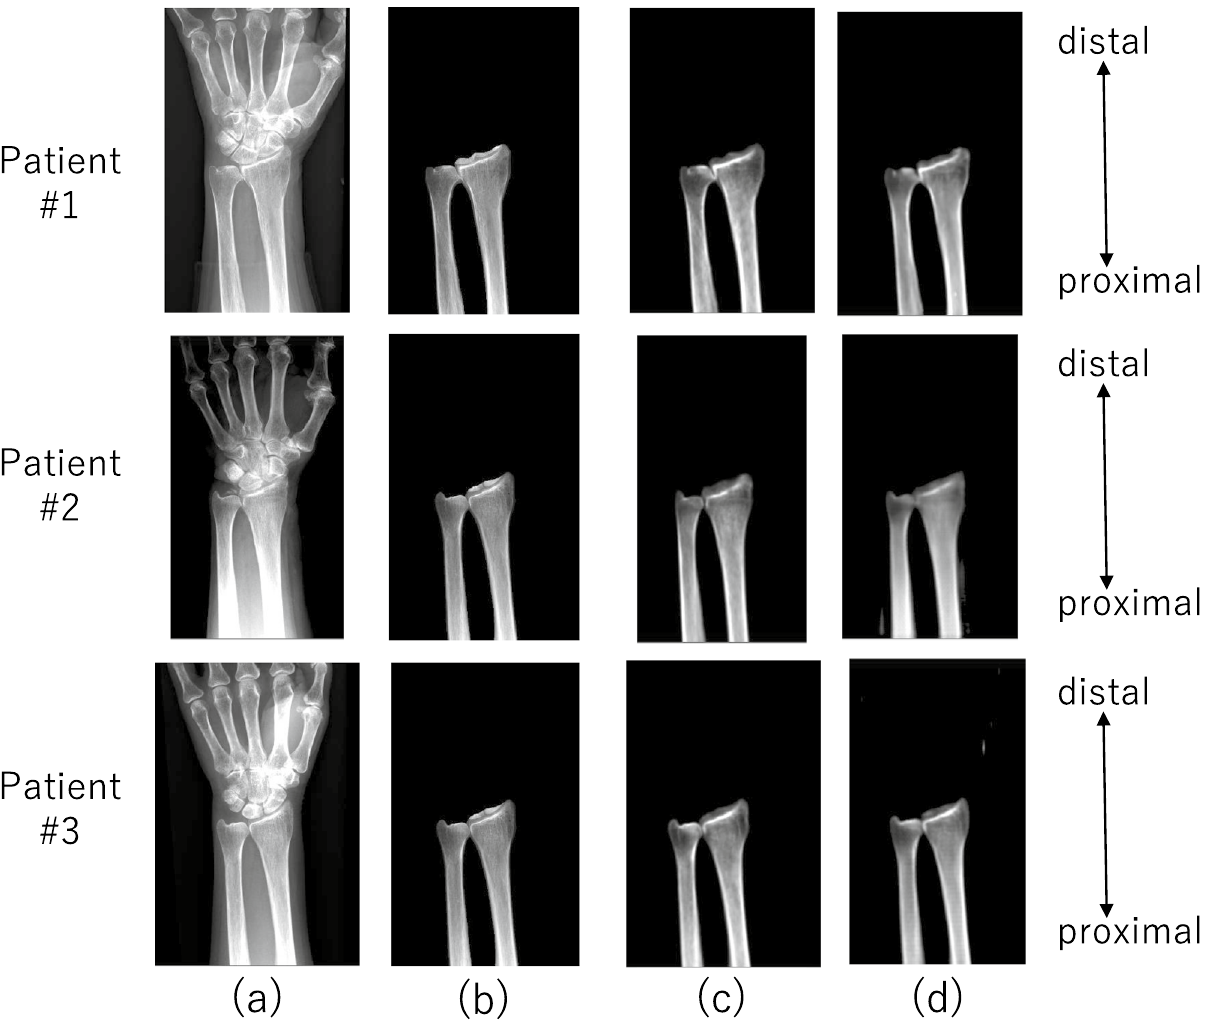
Figure 2. Image translation: ( a ) actual X-ray image; ( b ) actual X-ray image showing segmented radius and ulna; ( c ) registration-DRR; (d)